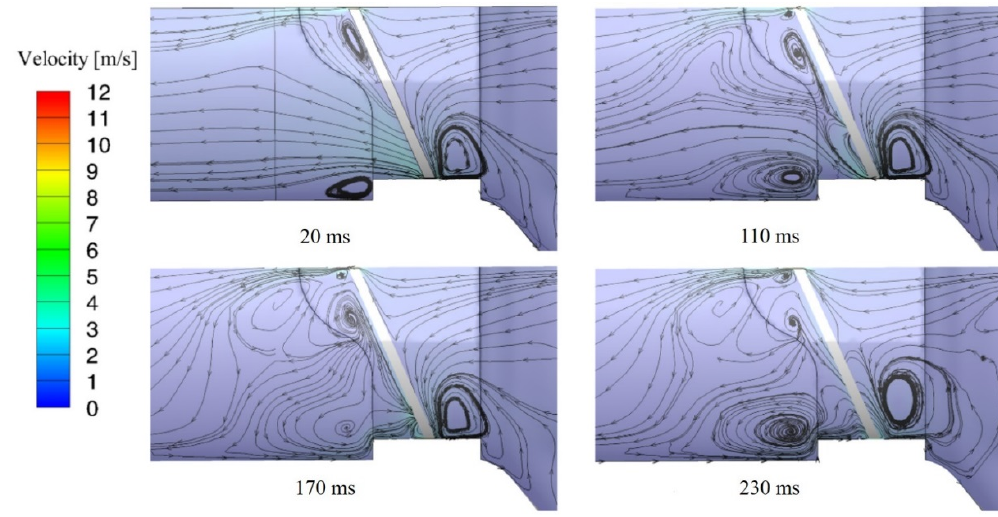
Figure 9. The streamline distributions after valve closing.